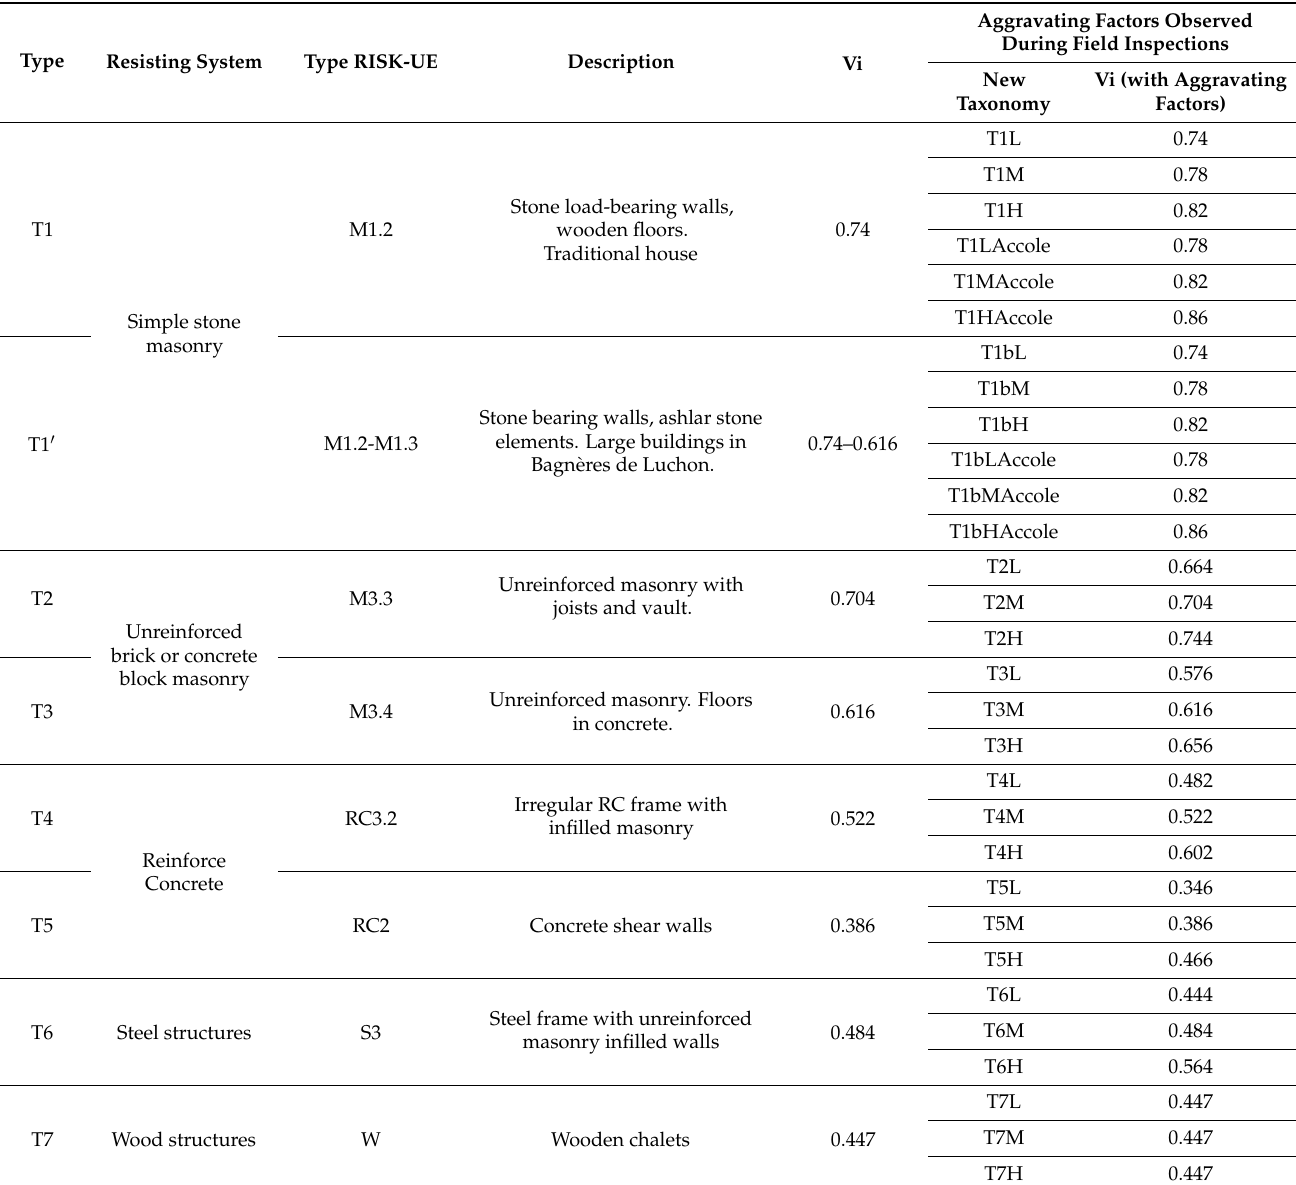
Table 4. Typology of buildings in the study area used in